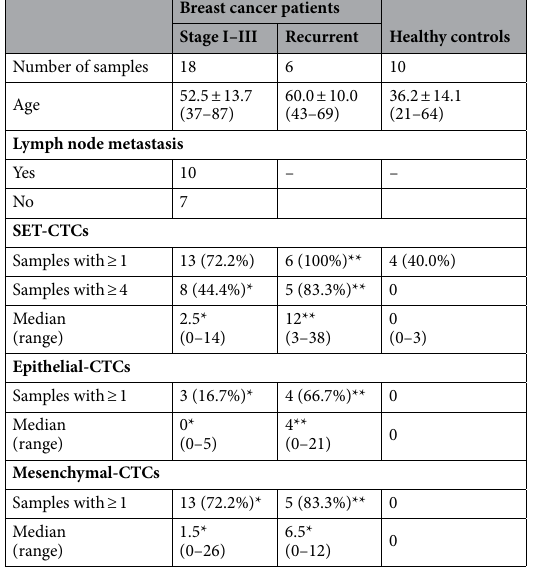
Table 2. Numbers of SET-CTCs, epithelial-CTCs, and mesenchymal-CTCs in breast cancer patients and healthy controls along with their characteristics. * P <0.05, ** P